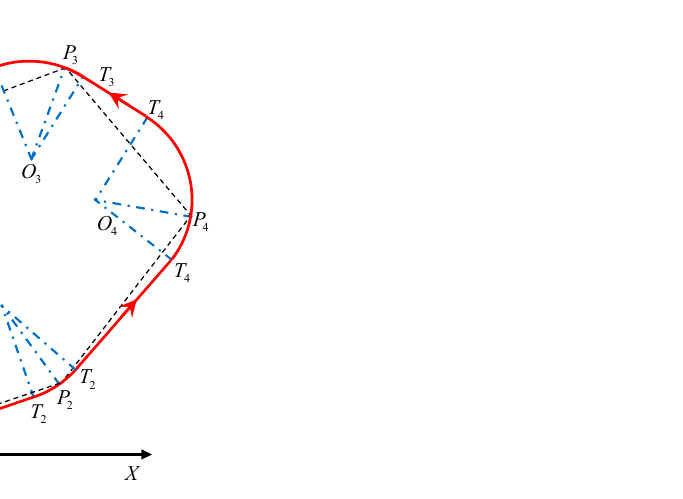
Figure 8. Representative HSA, Zeppelin NT airship adopted in the simulation study and validation.